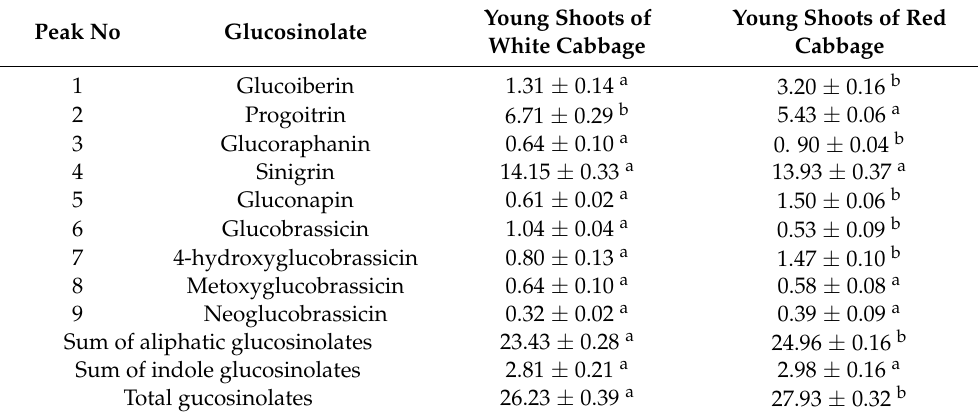
Young Shoots of Young Shoots of Red White Cabbage Cabbage